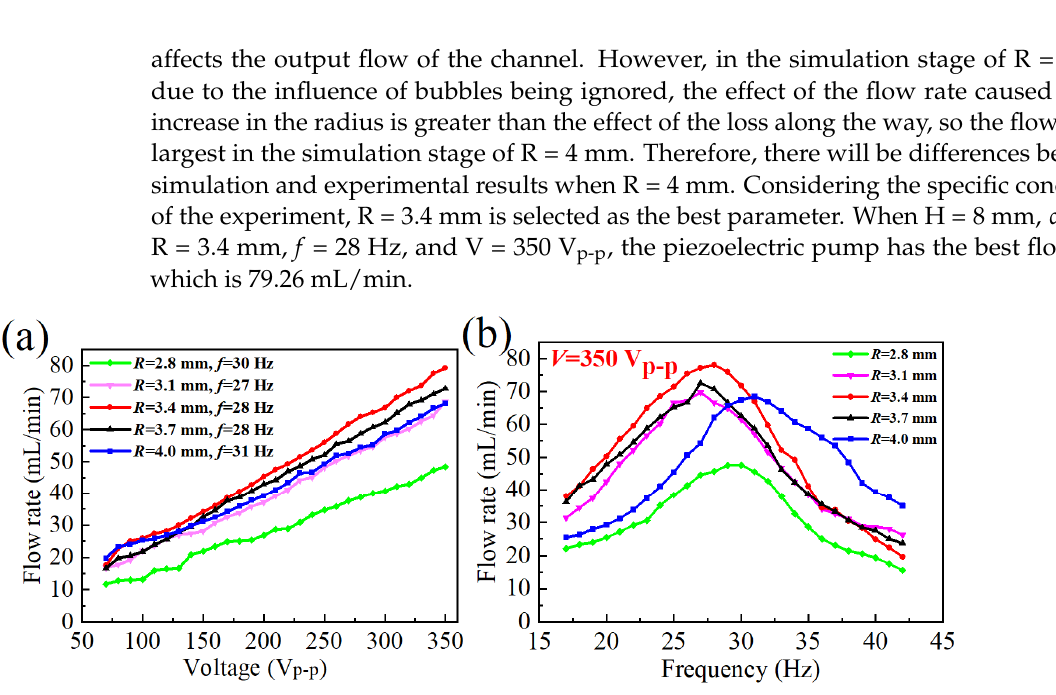
13 of 16 Figure 11. Corresponding maximum flow under different α . After gaining the two parameters of H = 8 mm and α = 30°, the determination of the third parameter (the radius of the channel R) was tested. The testing results were as fol ‐ lows: from Figure 12, it can be shown that the trend of flow rate with the radius of the Tesla valve at different voltages and frequencies is the same as testing H and α . From Figure 13, as the radius increases, the flow rate first increases and then decreases. The possible reason is that when the radius increases, in the scheduling stage (when the pie ‐